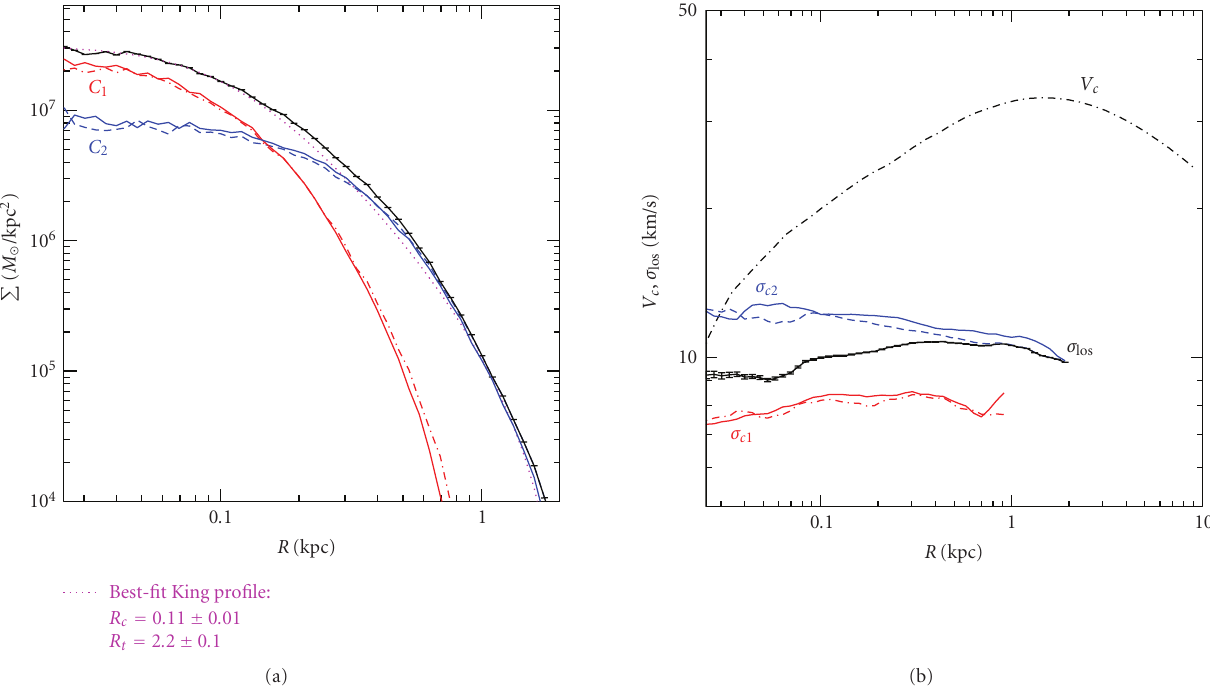
Figure 1: Surface mass density (a) and velocity (b) profiles for the simulated satellite as a function of the (projected) distance from the centre, R . (a), (b), red dot-dashed and blue-dashed curves distinguish the contributions from the more concentrated ( C 1 ) and more extended ( C 2 ) components, respectively, while the thick solid black shows the total values obtained for all the stars (i.e., no distinction between populations). In the left panel, the magenta dotted line shows the best-fit King profile obtained for the total distribution of stellar mass, and the numbers quoted correspond to the derived core and tidal radii, respectively. The right panel shows the circular velocity (black dashed) plus the line-of- sight velocity dispersion profiles associated to each luminous component. Poisson uncertainties are shown for the total density and velocity dispersion profiles in our model, although they are generally smaller than the thickness of the curves. Thin lines in (a), (b) correspond to a control model, which is evolved from this initial configuration in isolation during t ∼ 6